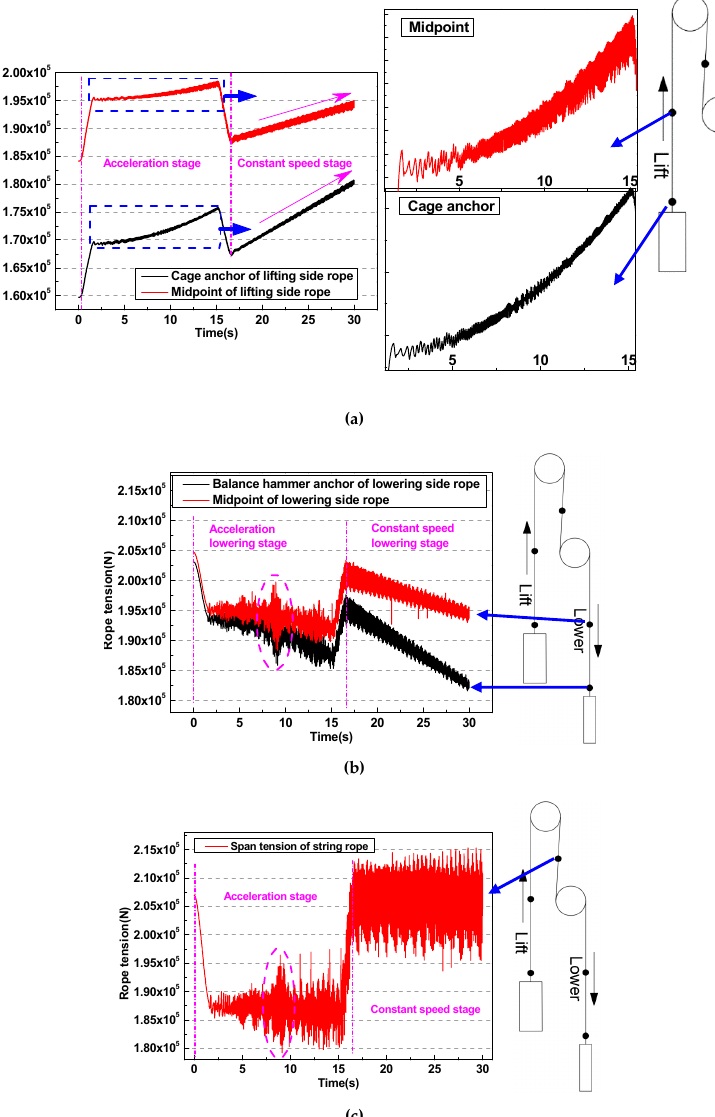
Figure 11. Dynamic rope tension at the different positions. ( a ) Tension at anchor and midpoint of lifting side rope; ( b ) Tension at anchor and midpoint of lowering side rope; ( c ) Tension at midpoint of the string rope.